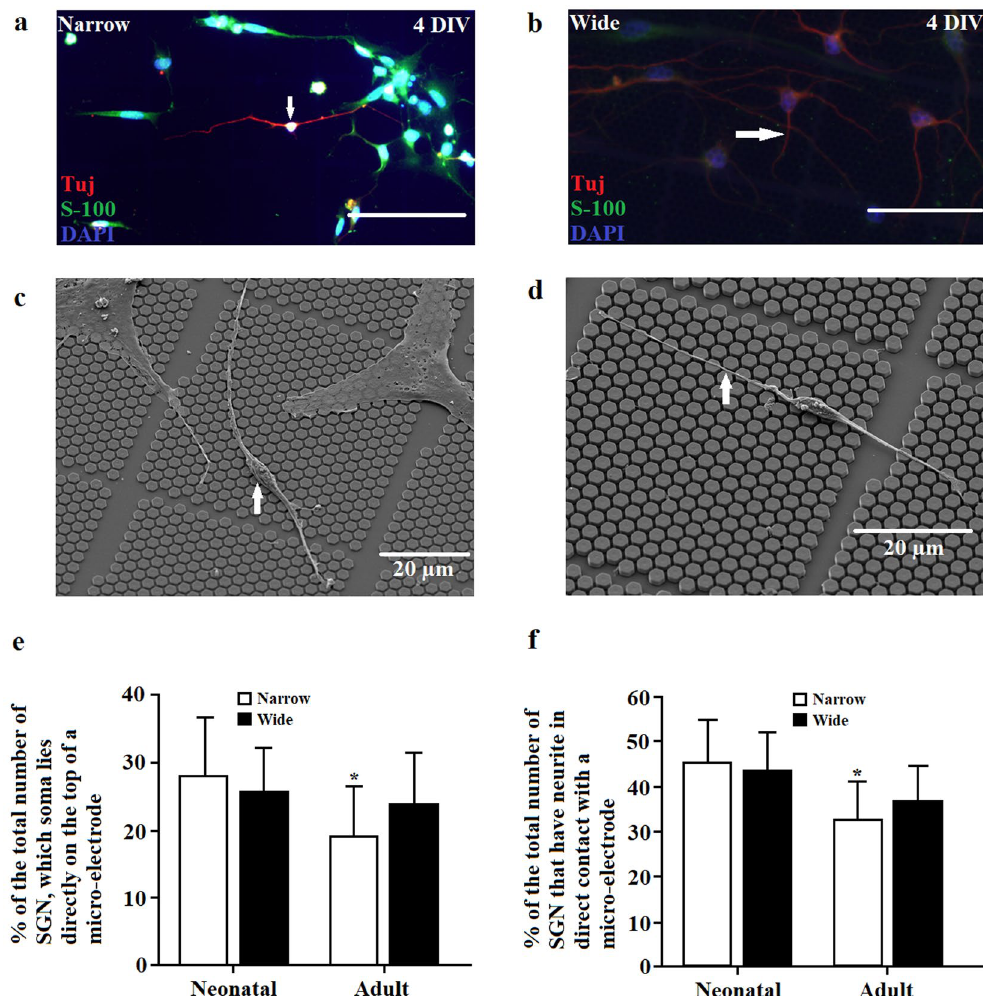
Figure 9. Contacts of the SGN soma and neurites with micro-electrodes. ( a ) Fluorescent image of a neonatal SGN with its soma being positioned directly on the top of a micro-electrode (white arrow). Cells were stained with the neuronal marker Tuj (red/magenta), glial marker S-100 (green), as well as with the nuclear marker DAPI (blue). Scale bar: 200 µ m. ( b ) Fluorescent image of a neonatal SGN with a neurite spanning a micro- electrode (white arrow). Cells were stained with the neuronal marker Tuj (red/magenta), glial marker S-100 (green), as well as with the nuclear marker DAPI (blue). Scale bar: 200 µ m. ( c ) SEM image of a neonatal SGN with its soma positioned directly on the top of a micro-electrode (white arrow). ( d ) SEM image of a neonatal SGN with neurite spanning a micro-electrode (white arrow). ( e ) Quantification of neonatal and adult SGNs with their somas positioned directly on the top of a micro-electrode. * indicates difference between neonatal and adult SGNs on narrow pillar area: * P < 0.05 (Student’s t-test). ( f ) Quantification of neonatal and adult SGNs with neurites spanning a micro-electrode. * indicates difference between neonatal and SGNs on narrow pillar area: * P < 0.05 (Student’s